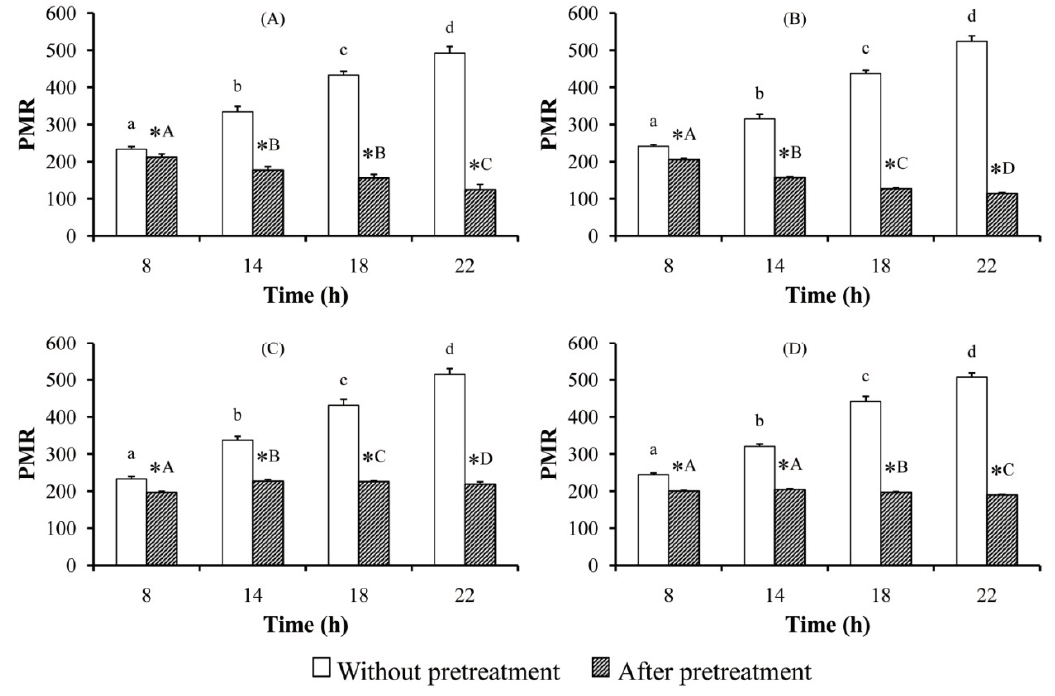
Figure 5. PMR † in rats receiving a single and multiple oral dose(s) of MG (40 mg/kg) and AE (100 mg/kg); ( A ) MG single dose; ( B ) MG multiple doses; ( C ) AE single dose; ( D ) AE multiple doses. † Mean ± SEM. Significance differences were considered at p < 0.05. Asterisk represents significant difference when compared with without pretreatment at the same time using paired t -test. A different letter (a lowercase for without pretreatment;